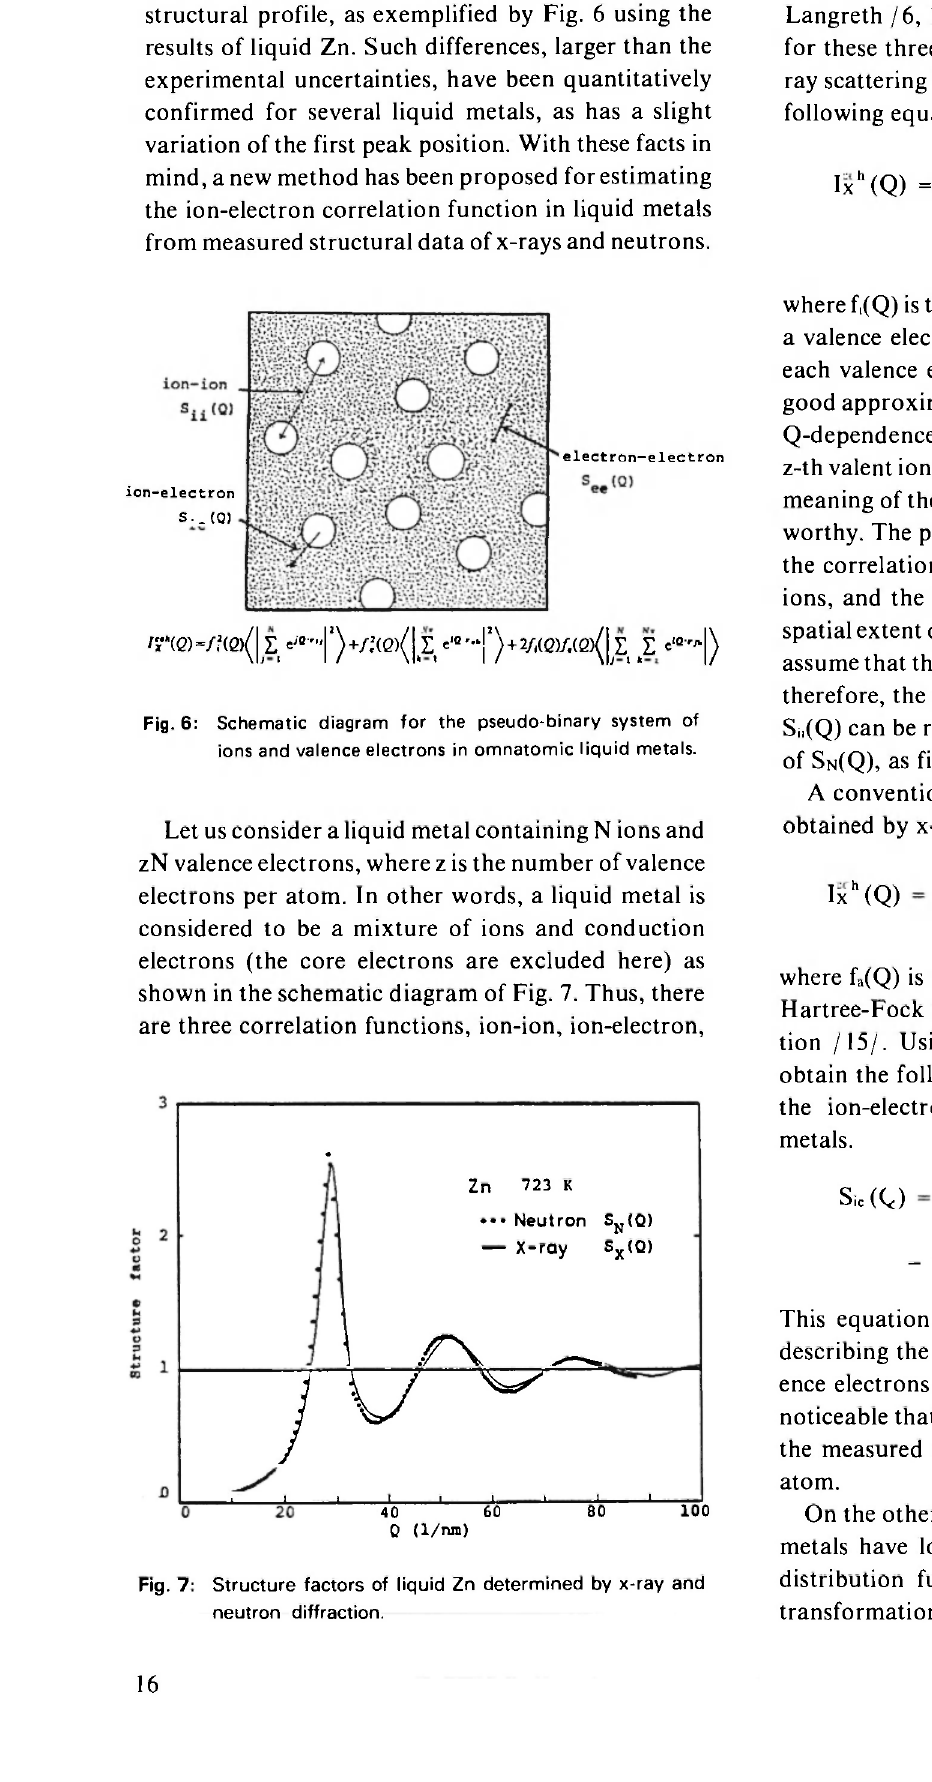
Fig. 7: Structure factors of liquid Zn determined by x-ray and neutron